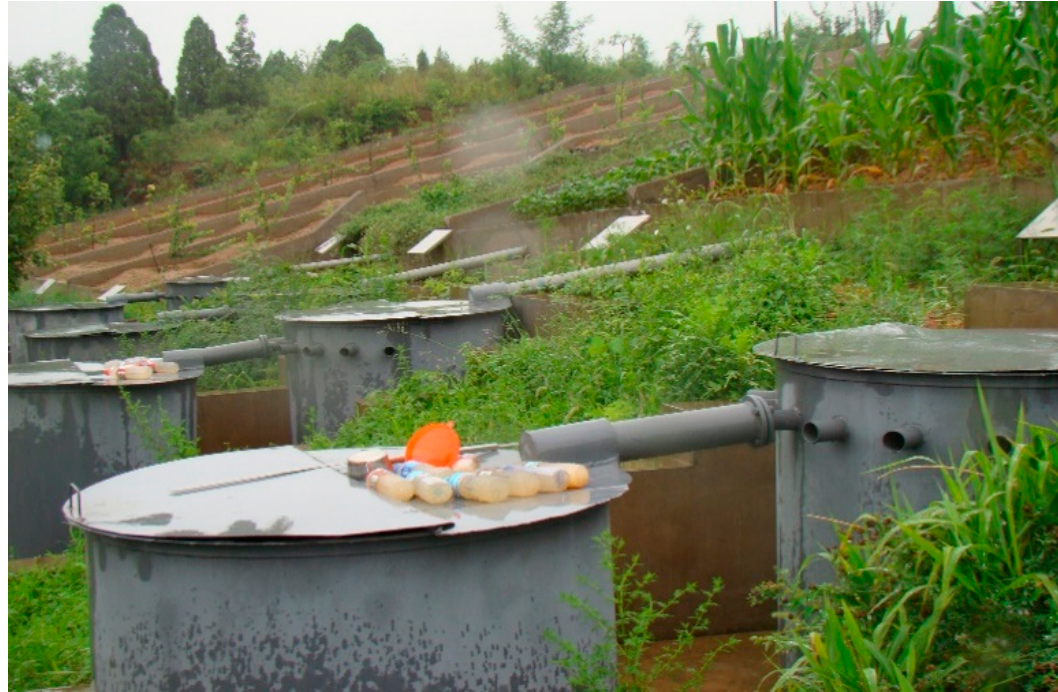
Figure 1. Runoff tanks.